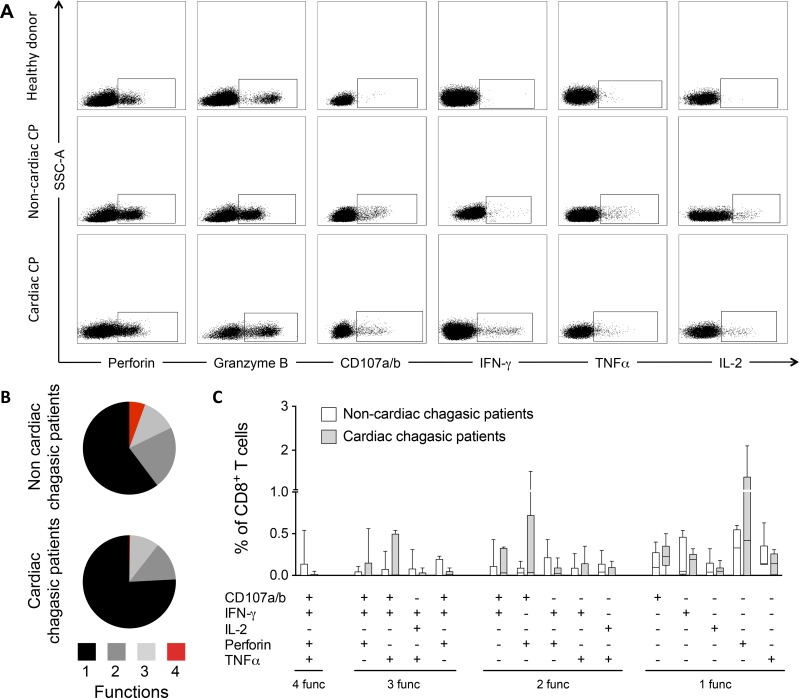
Polyfunctional profile of TcTLE-specific CD8+ T cell responses.(A) Functional cellular analysis of parasite-specific CD8+ T cells after stimulation with the TcTLE peptide. Gates were applied to identify cytokine-positive cells; these were defined according to the unstimulated samples for each subject. (B) The functional profiles of CD8+ T cells of HLA-A2-negative chagasic chronic patients were determined using a five-function detection method for CD107a/b, perforin, IFN-γ, IL-2 and TNFα after stimulation with the TcTLE peptide. The pie charts show the median percentages of responding CD8+ T cells grouped according to the number of simultaneous functions performed and color-coded depending on the functional profile. (C) Frequency of TcTLE-specific CD8+ T cells producing fifteen distinct combinations of five functions in non-CCC (white bars) and CCC patients (black bars). The results are shown as box-and-whisker (min-to-max) plots with median percentages of responding CD8+ T cells.